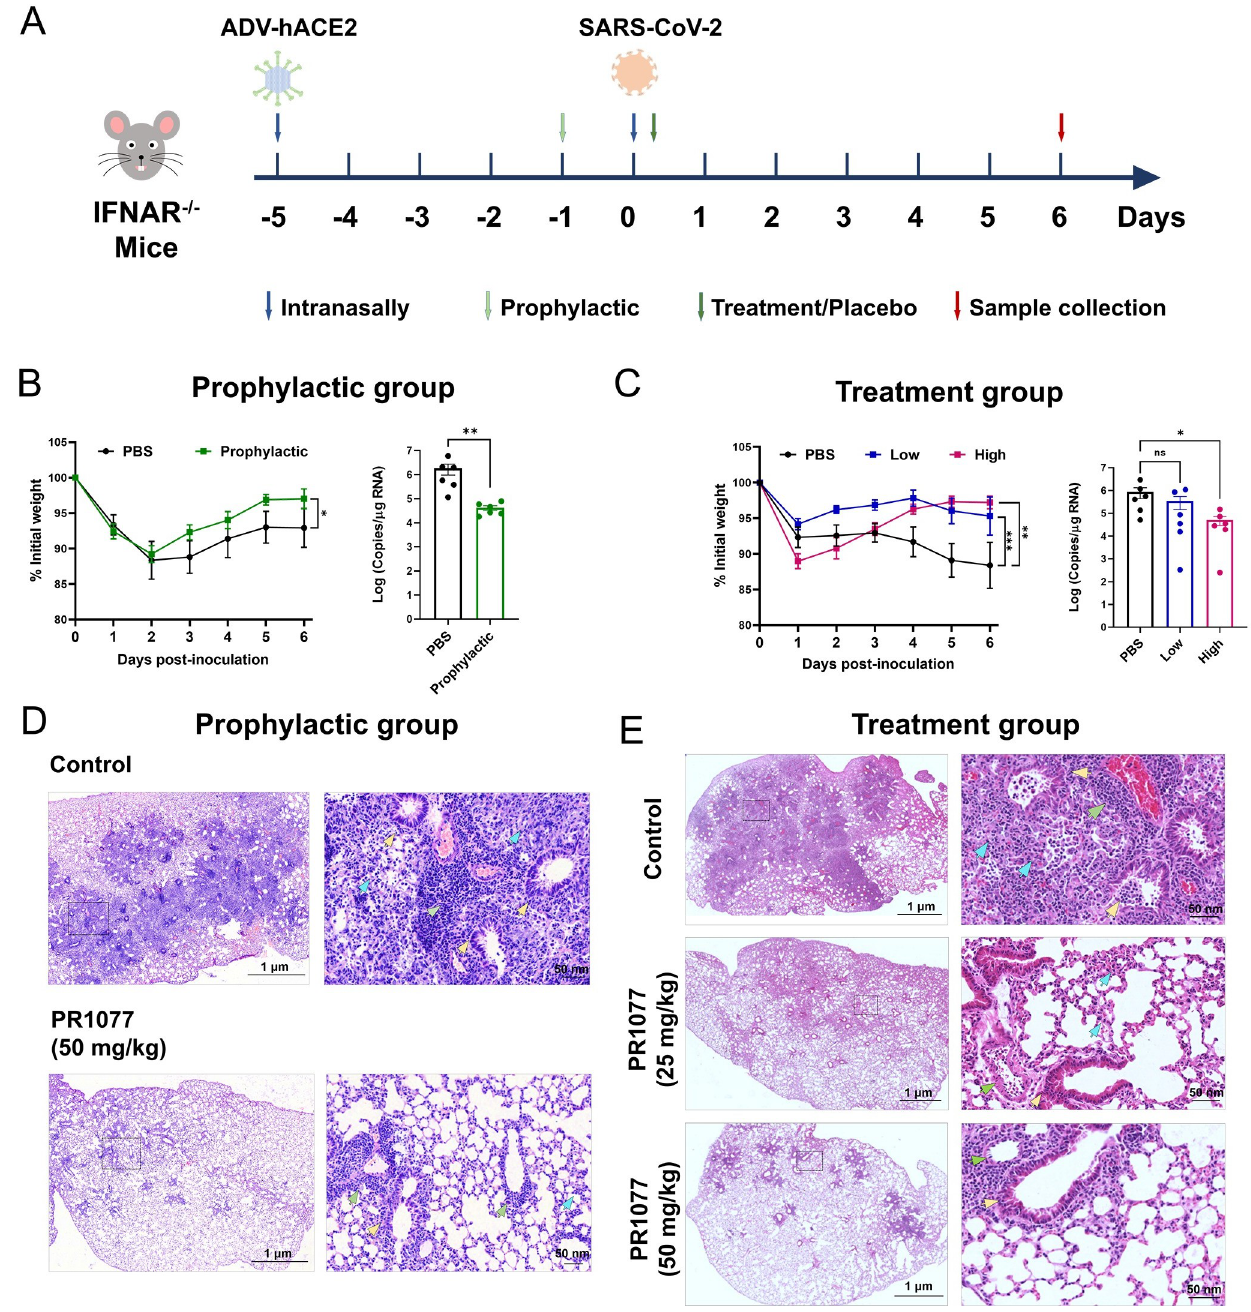
Fig 5. Therapeutic efficacy of PR1077 in SARS-CoV-2–infected AdV-hACE2-transduced mice. (A) Experimental design for PR1077 neutralization activity testing in AdV-hACE2-transduced IFNAR − / − mice. (B, C) Body weight changes and viral copies in the lung of infected mice were monitored. (B) For prophylactic efficacy testing, mice were intraperitoneally injected with 50 mg/kg of PR1077 or 200 μ l PBS ( n = 6 per group) at 24 hours before SARS-CoV-2 infection. All the data of this figure can be found in the S9 Data file. (C) For therapeutic efficacy testing, the animals were treated with PBS, 50 mg/kg, or 25 mg/kg of PR1077 at 2 h p.i. ( n = 6 per group). Weight changes were monitored daily, and viral copies in the lungs were measured at 6 d p.i. by qRT-PCR. All the data of this figure can be found in the S10 Data file. (D, E) Histopathological analyses of PR1077 treated or untreated mice infected with SARS-CoV-2. Representative images of lung sections stained by HE in the PR1077 prophylactic (D) and treatment (E) groups at 6 d p.i. a. Data are mean ± SEM. Blue, yellow, and green arrows indicate the pathological changes in the alveoli, bronchi/bronchioles, and blood vessels, respectively. The images on the right (bars = 1 μ m) are enlarged regions in the dashed boxes of the left images (bars = 50 nm). d.p.i., days post-infection; hACE2, human angiotensin-converting enzyme 2; HE, hematoxylin–eosin; h.p.i., hours post-infection; qRT-PCR, quantitative real-time PCR; SARS-CoV-2, Severe Acute Respiratory Syndrome Coronavirus